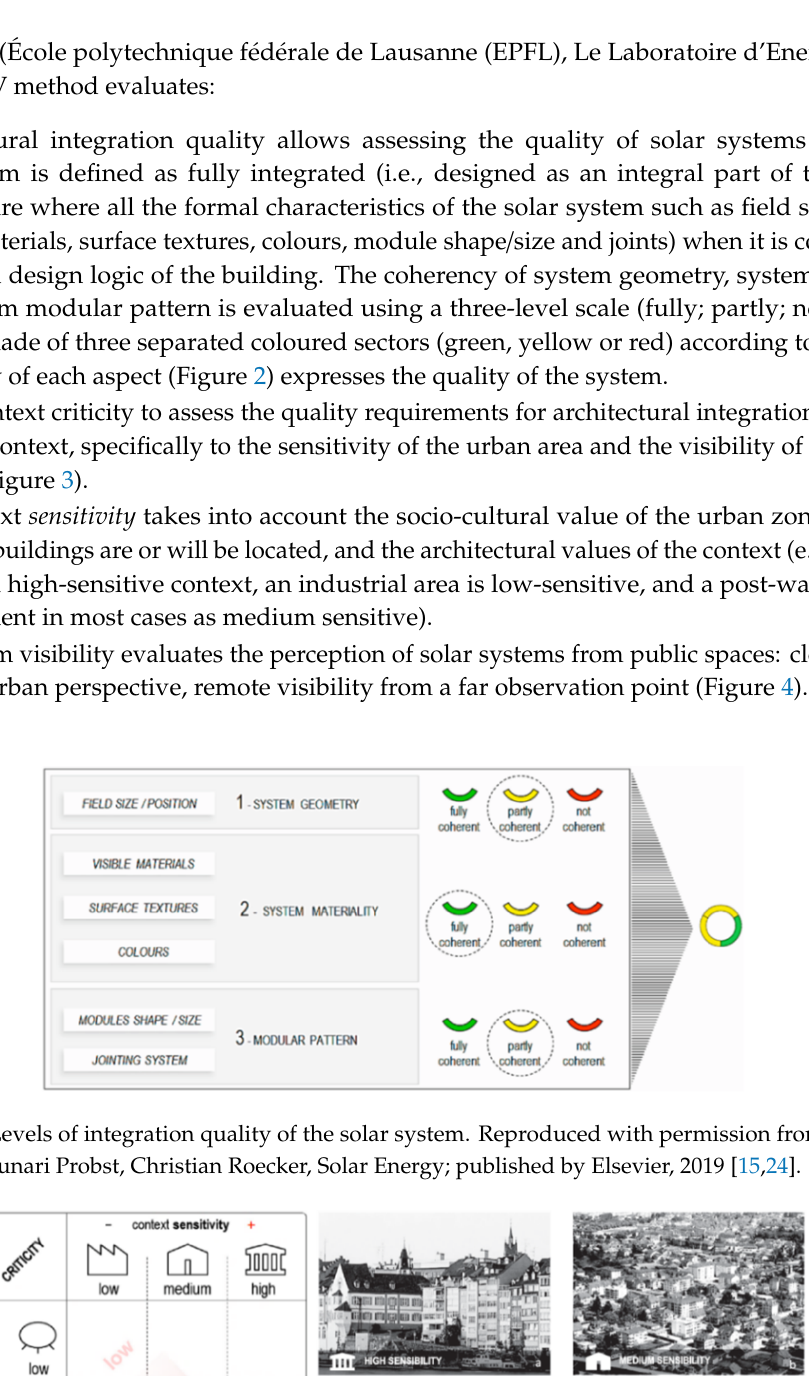
Figure 3. Criticity of city surfaces in relation with surface visibility and context sensitivity ( on the left ); Different levels of urban context sensitivity ( on the right ) Reproduced with permission from Maria Cristina Munari Probst, Christian Roecker, Solar Energy; published by Elsevier, 2019 [15,24].